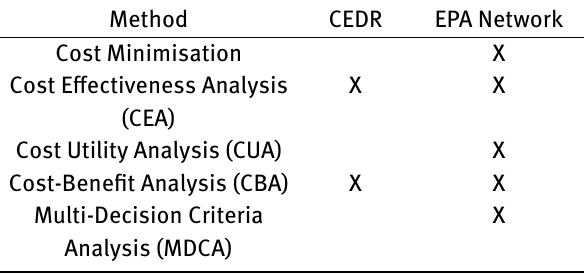
Table 1: Proposed methods of analysis